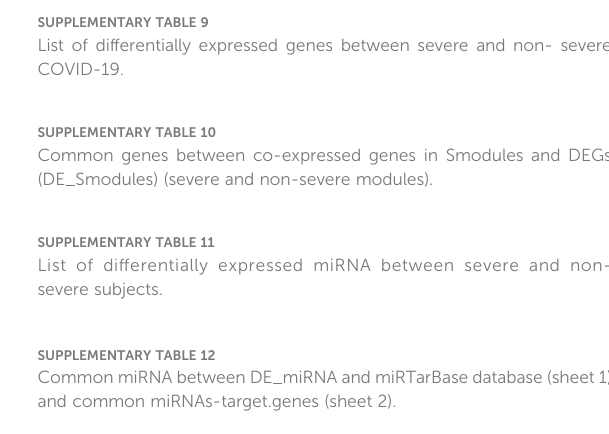
SUPPLEMENTARY TABLE 9 List of differentially expressed genes between severe and non- severe COVID-19.